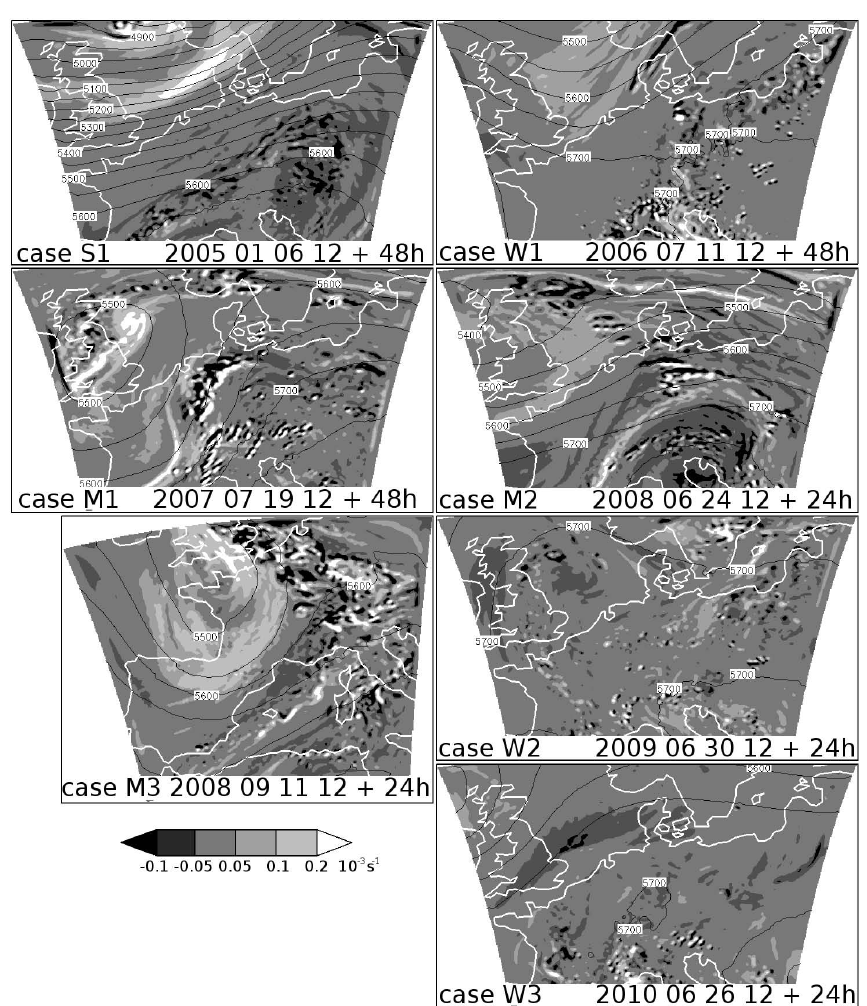
Fig. 2. 500hPa relative vorticity (s − 1 , shaded), and geopotential height (m, in black contours) for selected